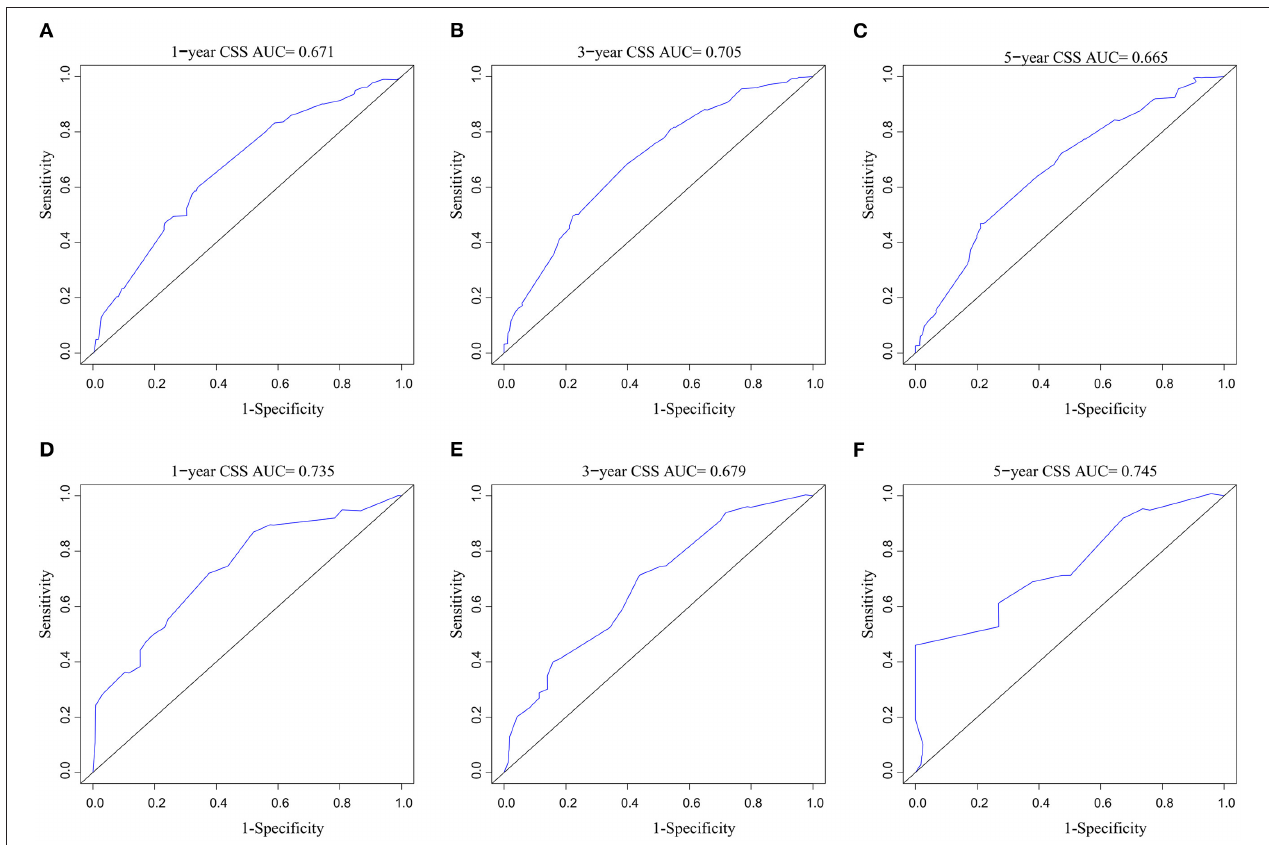
FIGURE 3 | AUC value of ROC predicting: (A) 1-year CSS of the nomogram in the training set; (B) 3-year CSS of the nomogram in the training set; (C) 5-year CSS of the nomogram in the training set; (D) 1-year CSS of the nomogram in the validation set; (E) 3-year CSS of the nomogram in the validation set; (F) 5-year CSS of the nomogram in the validation set. AUC, area under the curve; ROC, receiver operating characteristic; CSS, cancer-specific